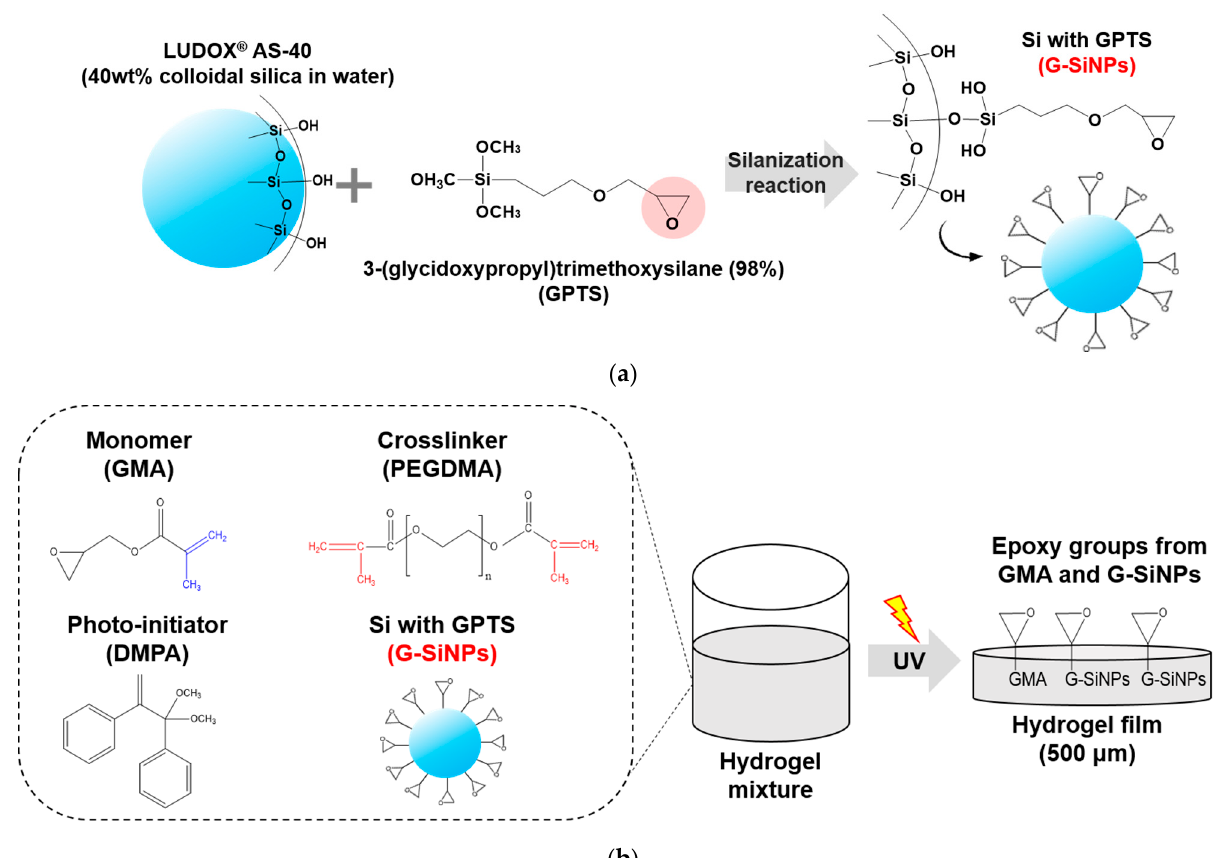
Figure 1. ( a ) Preparation of G-SiNPs by silanization between Si-NPs and GPTS. ( b ) Schematic illustration of a cured hydrogel film with epoxy rings on the surface after UV curing of the hydrogel mixture.